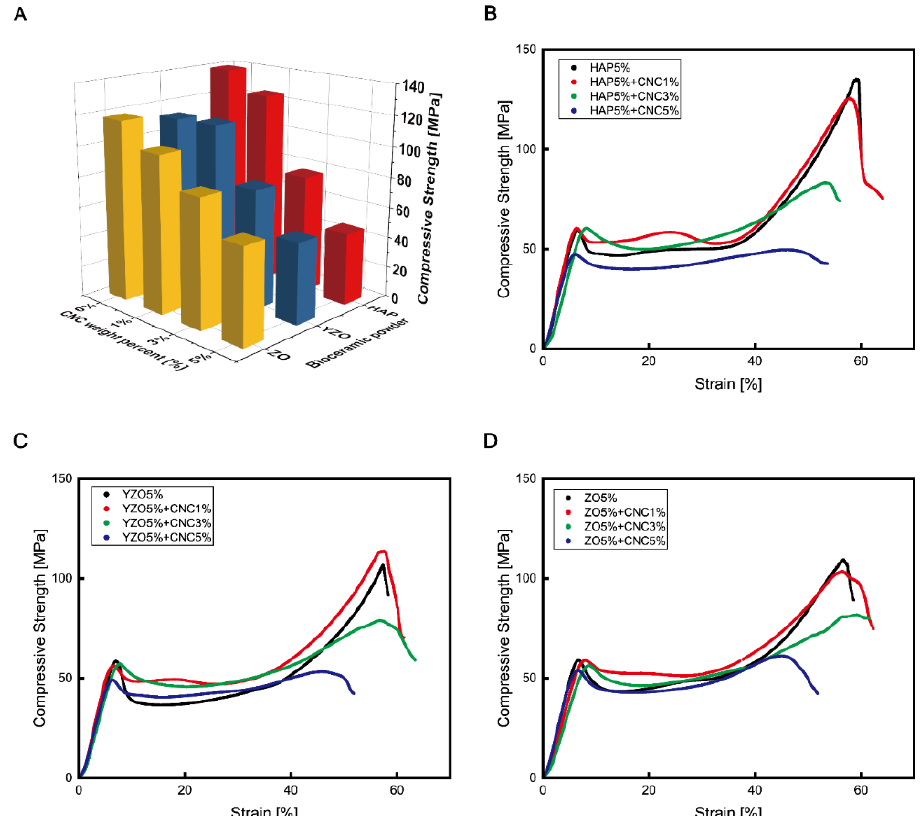
Figure 5. ( A ) Comparison of compressive strength vs. strain changes according to CNC weight percentage in each bioceramic–epoxy composite material. ( B ) Compressive strength vs. strain in HAP–epoxy composite material as function of CNC content. ( C ) Compressive strength vs. strain in YZO–epoxy composite material as a function of CNC content. ( D ) Compressive strength vs. strain in ZO–epoxy composite material as a function of CNC content.